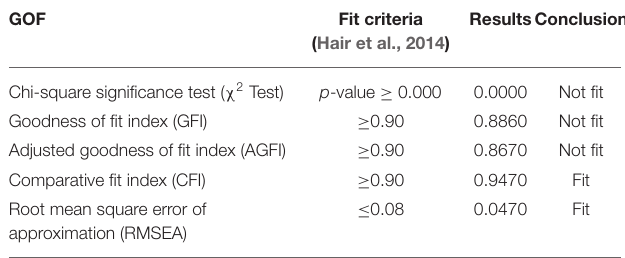
TABLE 11 | Goodness of fit test